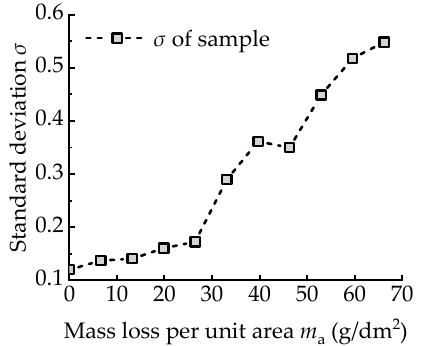
Figure 8. Variation of standard deviation σ with corrosion degree m a .